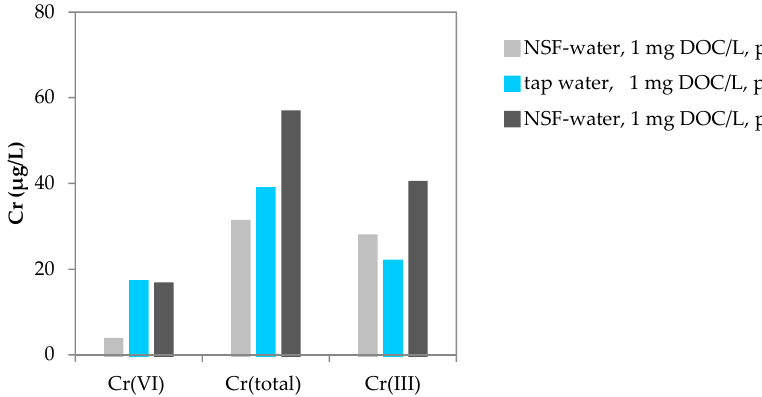
Figure 10. Cr(VI), Cr(total), and Cr(III) from tap water (pH 7.8, 1.3 mg DOC/L) and from NSF water (pH 7 and 8, 1 mg DOC/L) at the Fe(II) dosage 2 mg/L. All experiments were performed using set-up A.